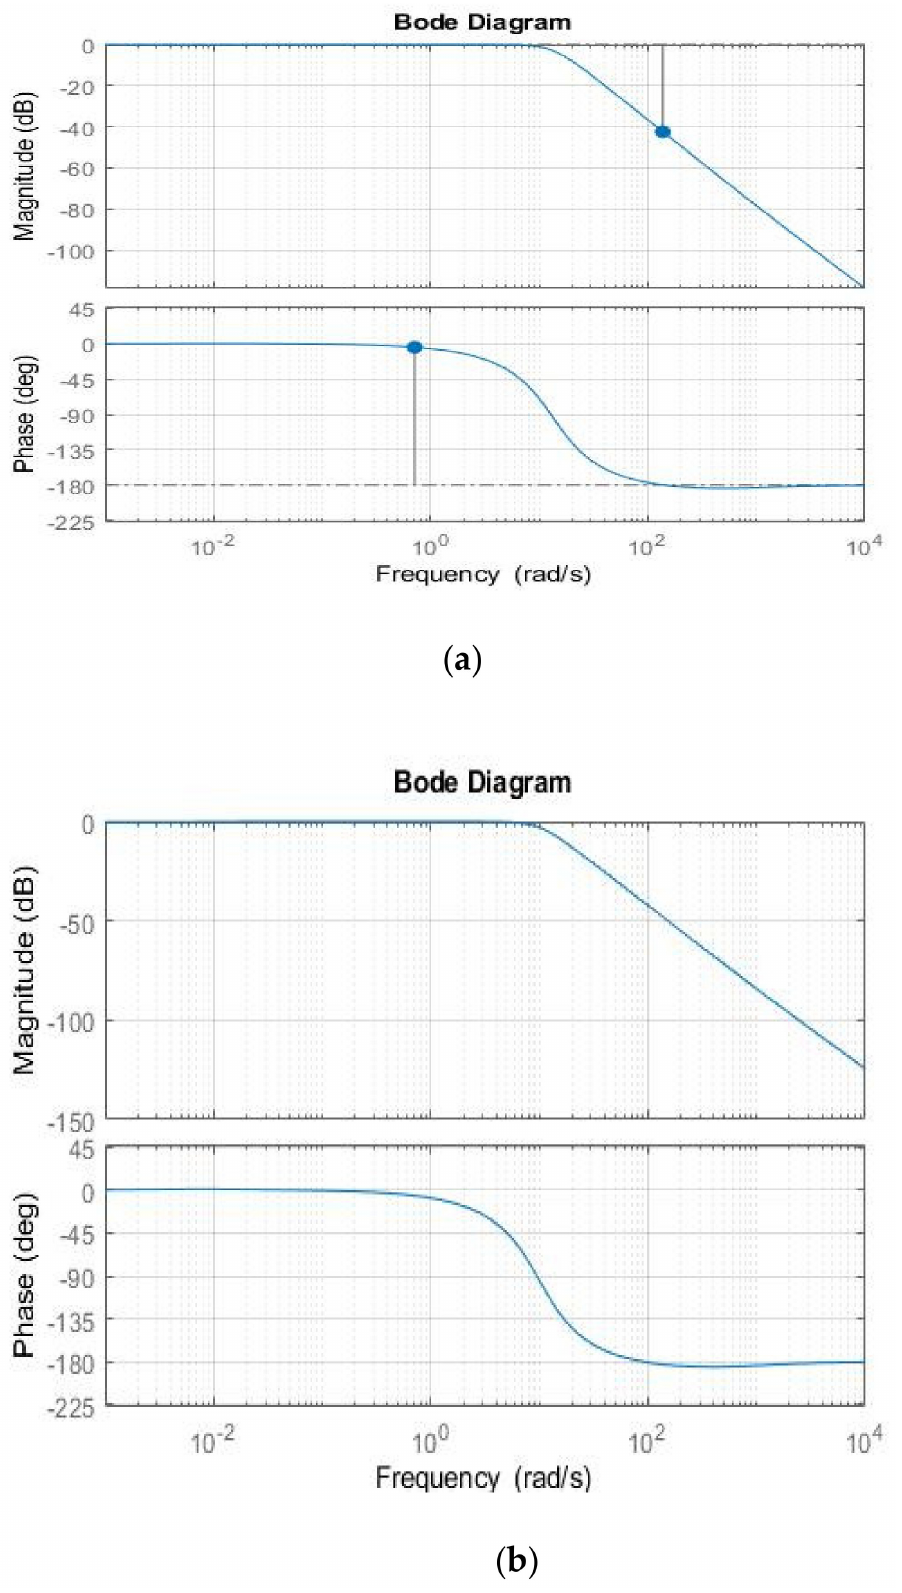
Figure 11. ( a ) Closed-loop Bode plots of LQR-FI compensator for λ = 0.1 : fault − free, and ( b ) closed-loop Bode plots of LQR-FI compensator with 50% loss of actuator effectiveness for λ =